Question: What type of chart is this?
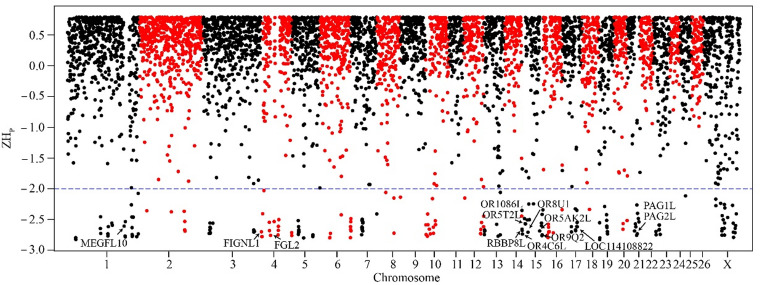
Answer: line